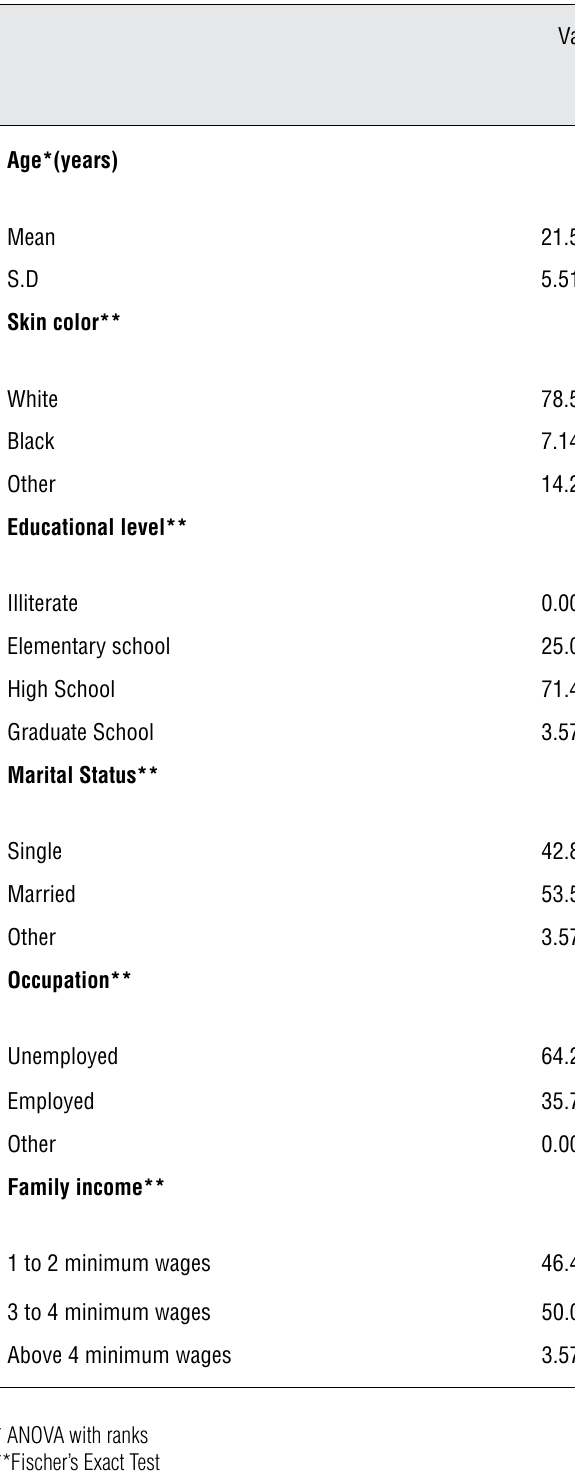
Table 2 - Demographic